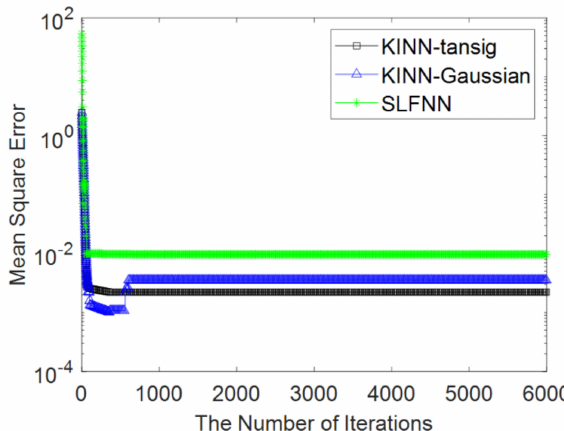
Figure 15. The training error (MSE) curves of KINN-tansig, KINN-Gaussian, and SLFNN for the Egg reservoir case. The black line with squares is the error curve of KINN-tansig; the blue line with triangles represents the error curve of KINN-Gaussian, and the green line with stars represents the error curve of